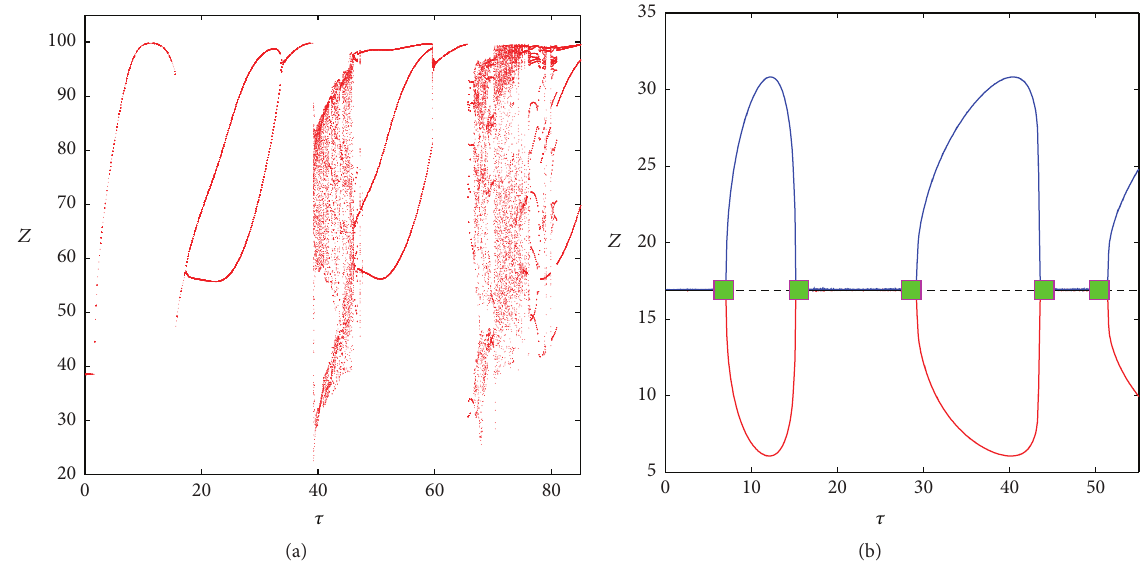
Figure 6: (a) Bifurcation diagram of system (3) with 𝛼 = 0.5 and initial point (0.6, 0.7, 16); (b) the stability switches of positive equilibrium in the component 𝑍 with respect to time delay 𝜏 for 𝛼 = 0.2991 and 𝑍 ∗ = 16.92598 , where the green point denotes the Hopf bifurcation point, the black solid line denotes the stable positive equilibrium, the black dashed line denotes the unstable positive equilibrium, and the blue and red curves denote the maximum and minimum values of zooplankton density 𝑍 ,